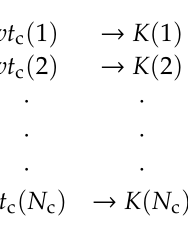
Figure 13. Separation algorithm model of the combined projection curve.